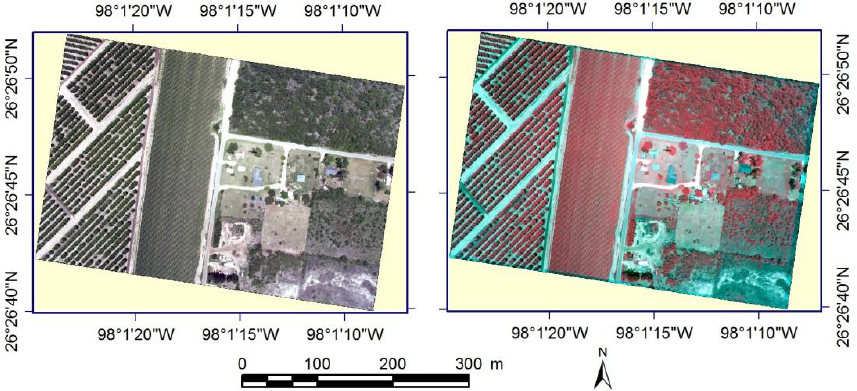
Figure 4. Normal color ( left ) and color-infrared ( right ) images acquired at 305 m (1000 ft) above ground level on 17 May 2012 from an area with diverse ground cover types in South